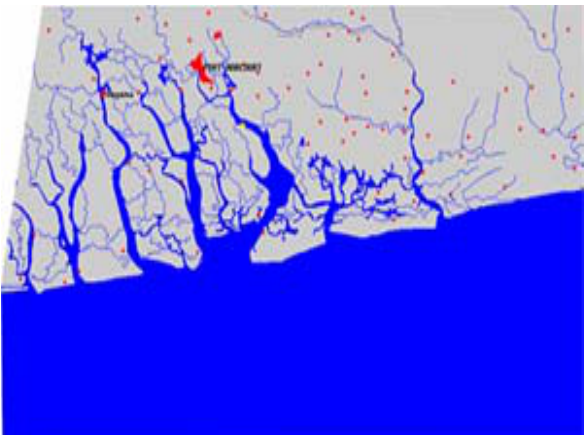
Figure 5: Population clusters in the study area Factors Responsible for Environmental Change and the Frameworks in Place Misguided Economic Policy and Over Dependency